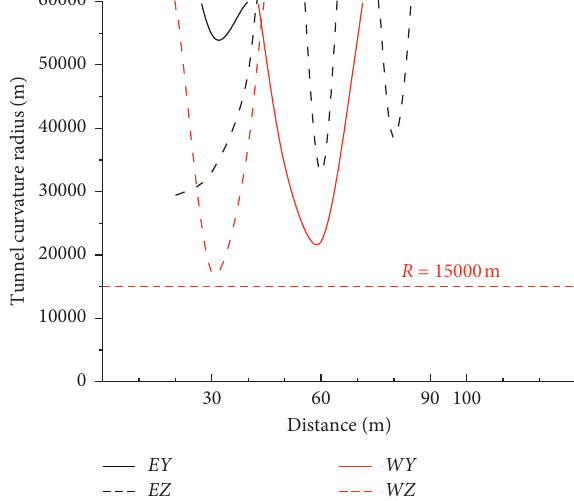
Figure 12: Variations in tunnel curvature